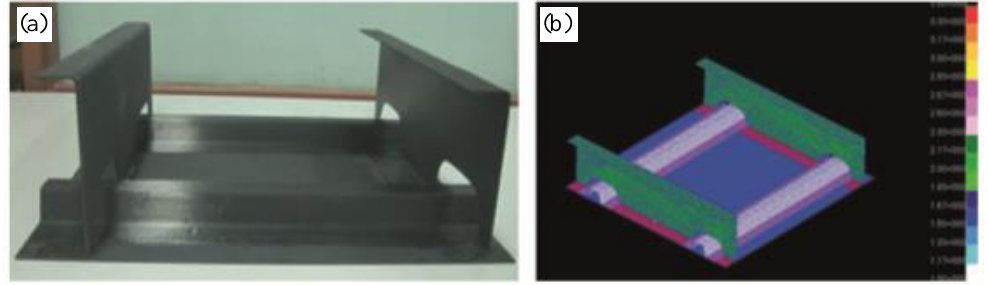
Figure 18. ( a ) Composite specimen representing a typical aeronautical construction; ( b ) FE model of the specimen